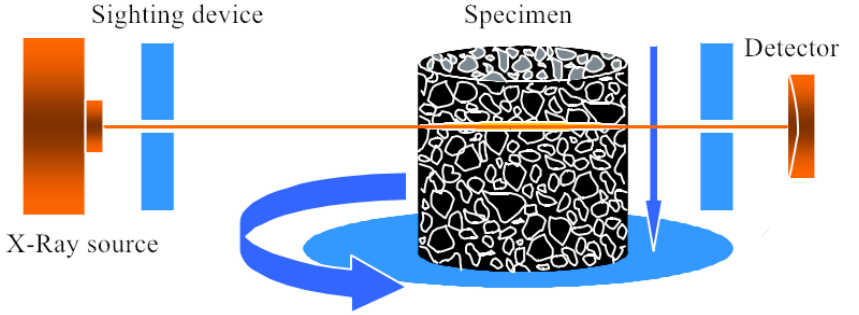
Figure 2. Principle of typical CT system.